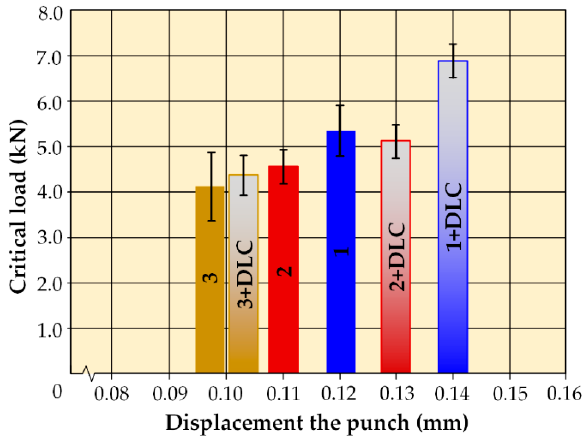
Figure 14. The relationship between the critical (breaking) load, the path of punch movement until the fracture of ceramic samples sintered from various powder compositions, where (1) is 80% (90 α 10 β ) + 20% TiN, (2) is for 90% (90 α 10 β ) + 10% TiN, and (3) is for 80% (70 α 30 β ) + 20% TiN before and after DLC coating deposition.